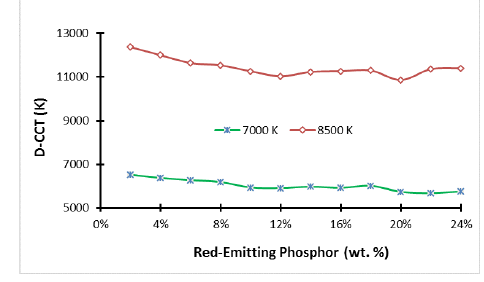
Fig. 8: D-CCT of WLEDs with various α - SrO · 3B 2 O 3 :Sm 2+